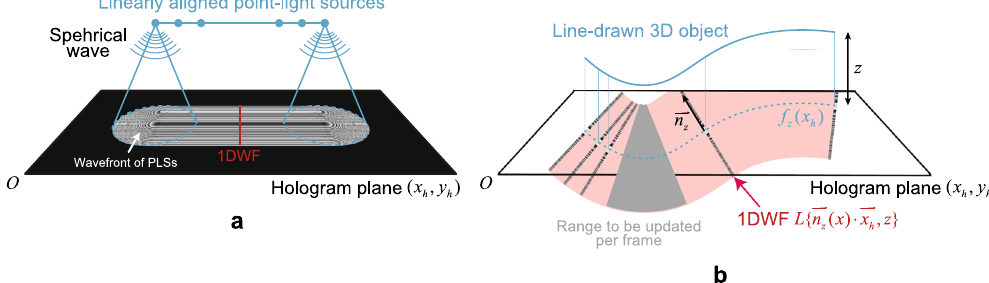
Figure 1. Overview of the CG-line method. ( a ) Principle of obtaining 1DWF. ( b ) Method to create CGH using the CG-line method in the proposed system.